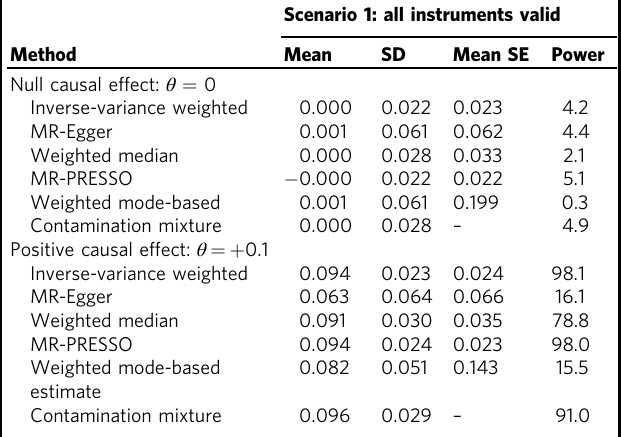
Table 1 Comparison of methods when all genetic variants are valid